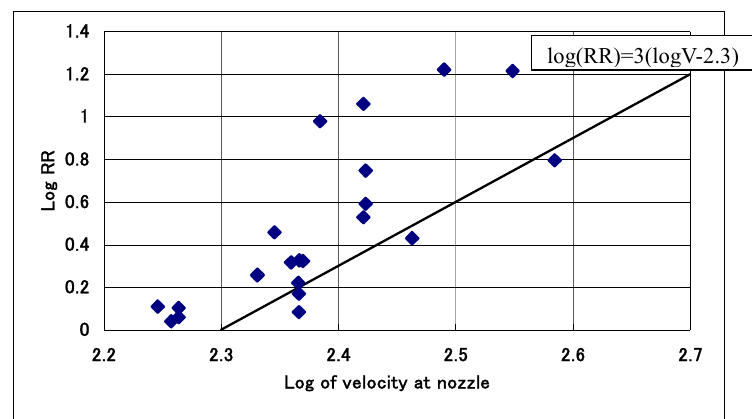
Fig. 15 Log RR (reduction rate) vs log of velocity at upstream nozzle for E. coli